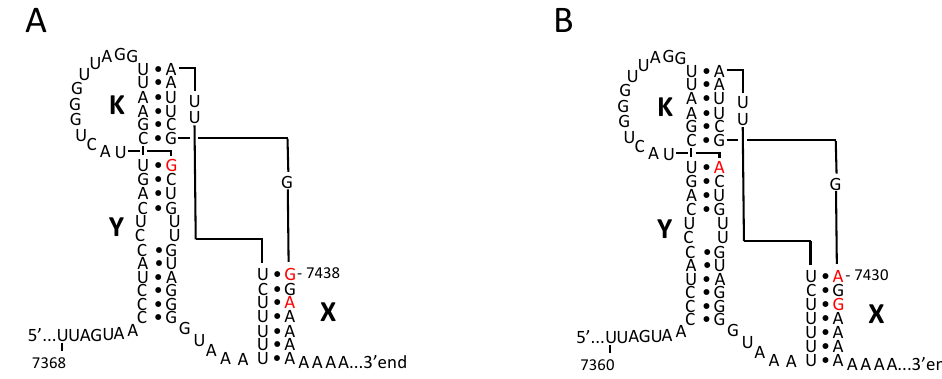
Figure 4. Schematic representation of the possible 3 ′ -terminal tertiary structures of the RNAs of Sabin-2 ( A ) and Sabin-3 ( B ) polioviruses. It shows the helical elements of hairpins X and Y as well as the tertiary kissing interaction between these hairpins (K). The nucleotides distinguishing these two 3’UTRs are highlighted in red. Of note, these distinctive nucleotides in Sabin 1 RNA are the same as in Sabin 3. Modified from [35].